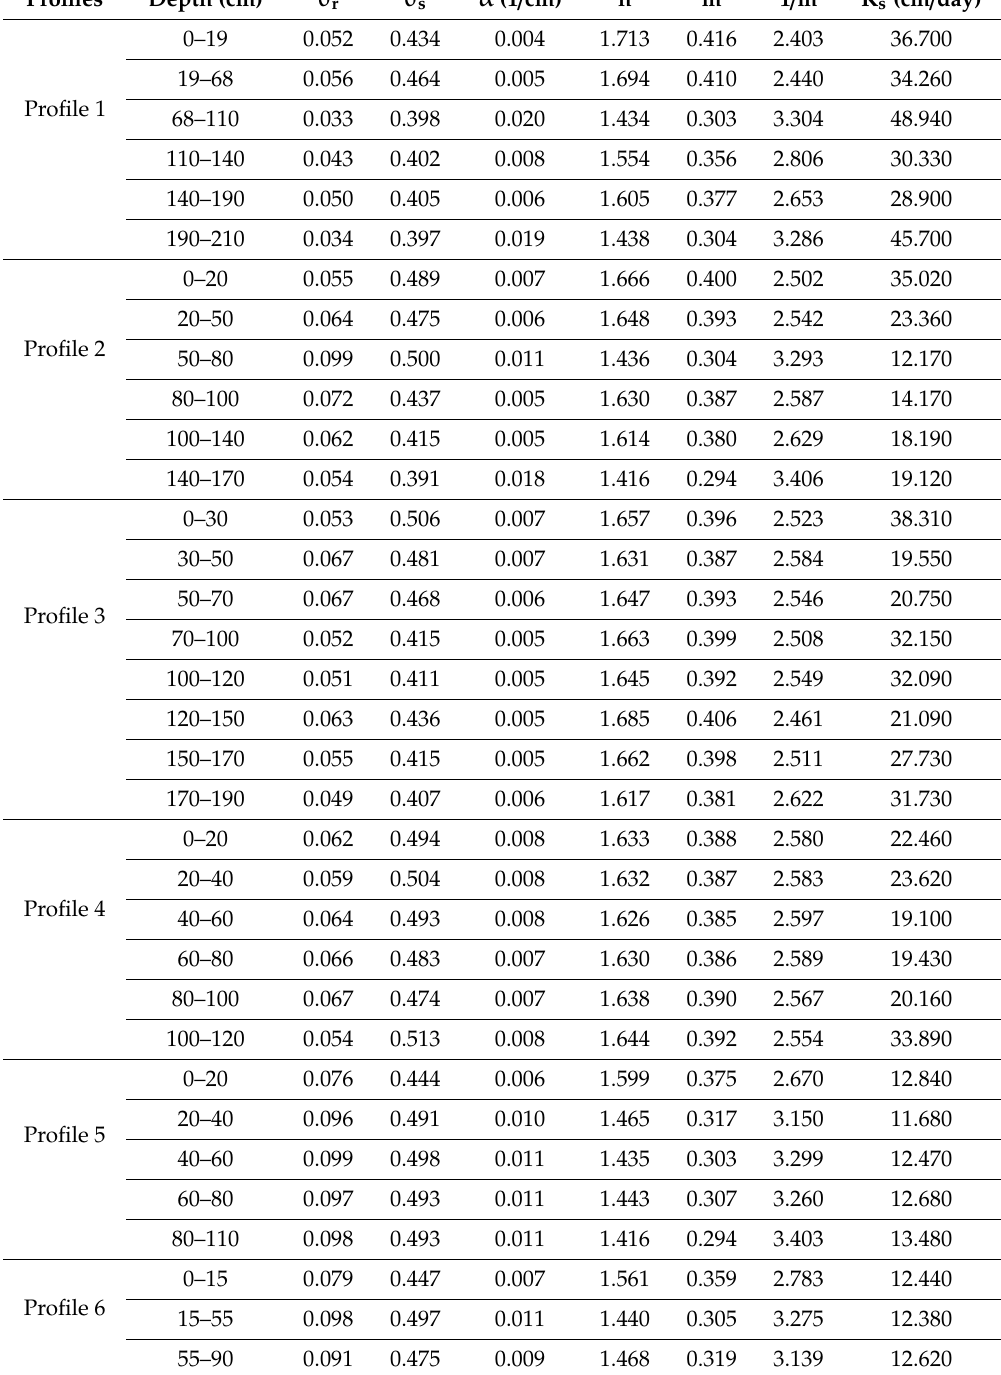
Table 2. Soil hydraulic parameters of the investigated soil profiles by